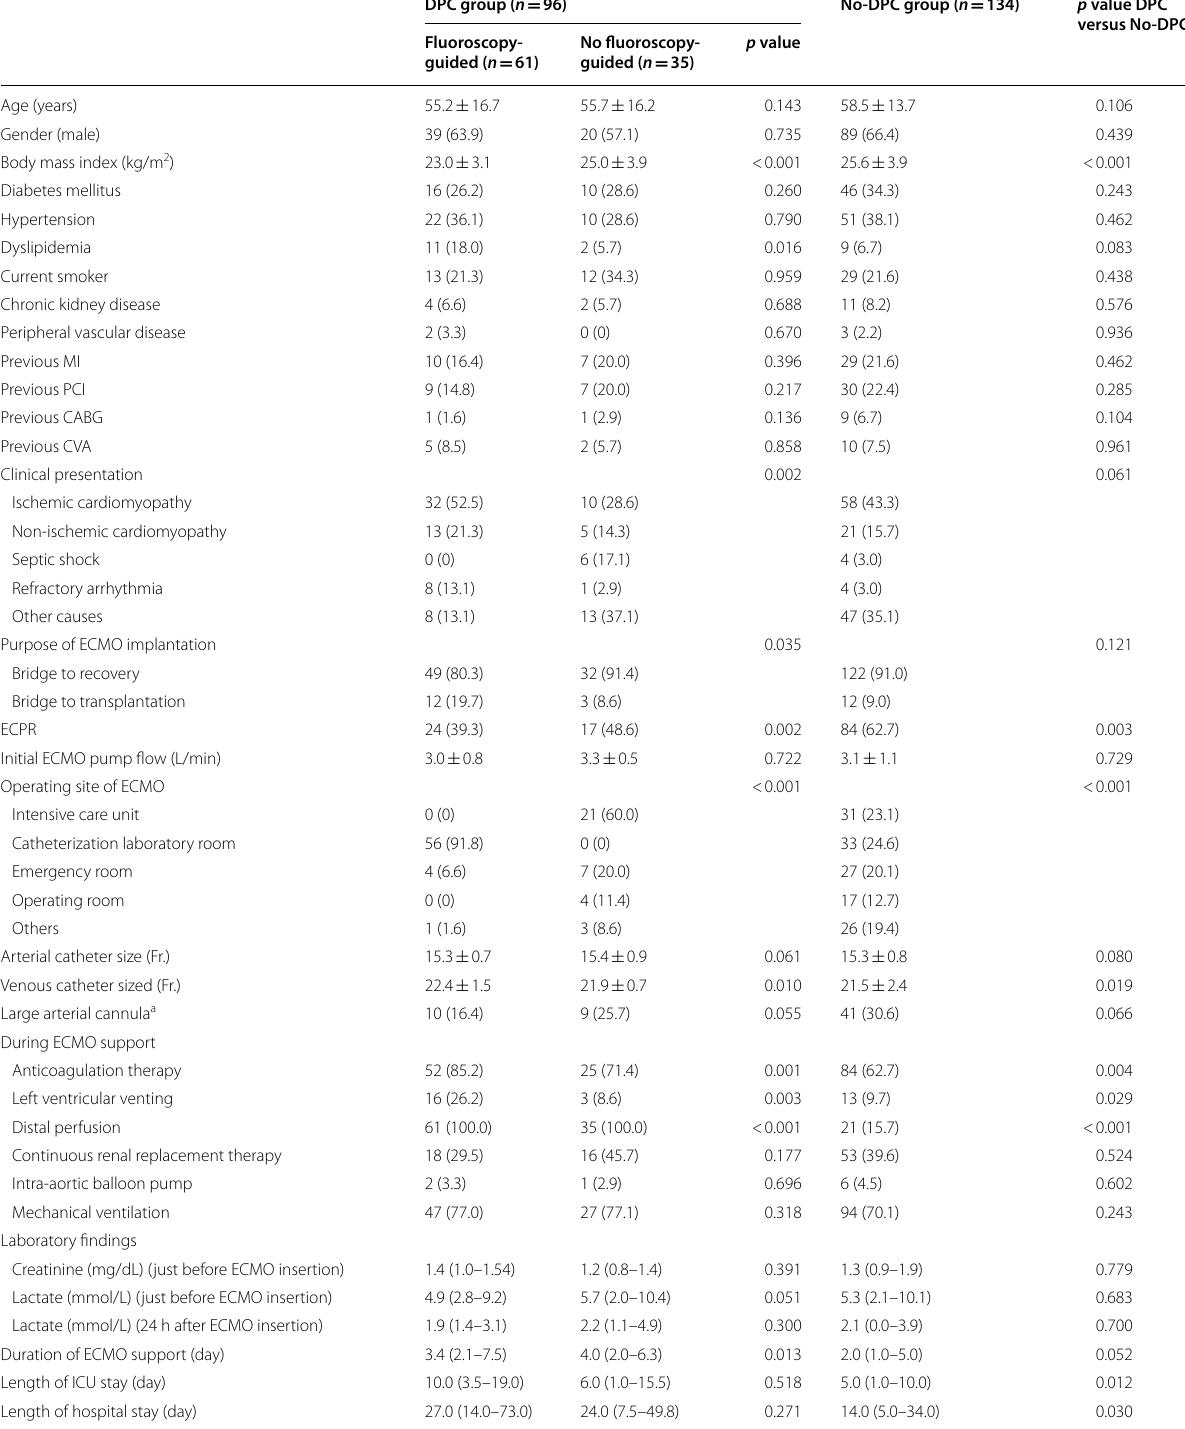
Table 1 Baseline and procedural